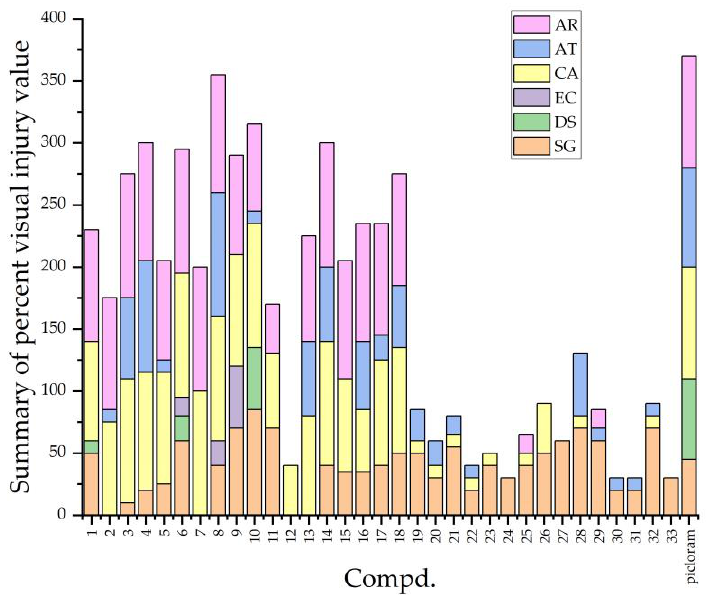
Figure 9. Accumulated visual injury of compound V and picloram under post-emergence treatment. Table 6. Crop selectivity of compound V-8